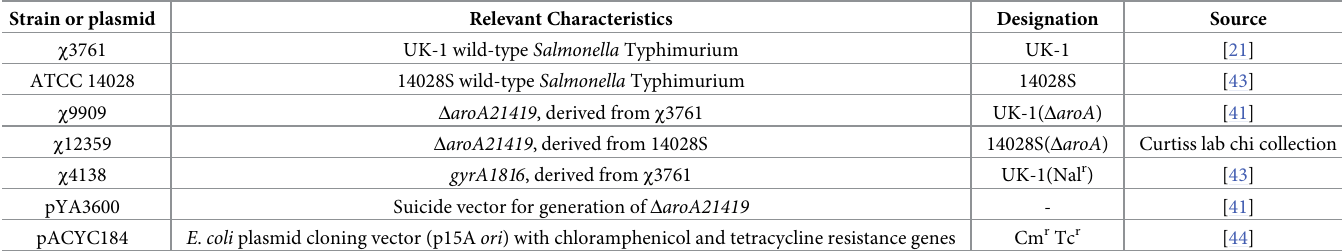
Table 1. Characteristics of the strains and plasmids used in this study. Strain or plasmid Relevant